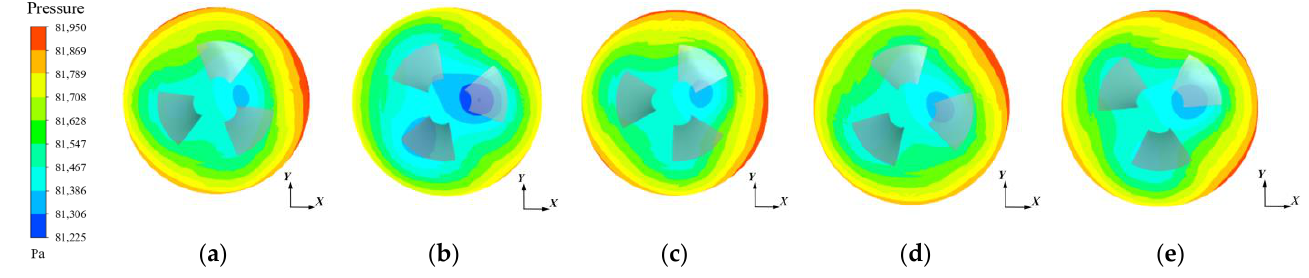
Figure 20. Pressure distribution at the bell mouth at different time points. ( a ) 1/5T. ( b ) 2/5T. ( c ) 3/5T.